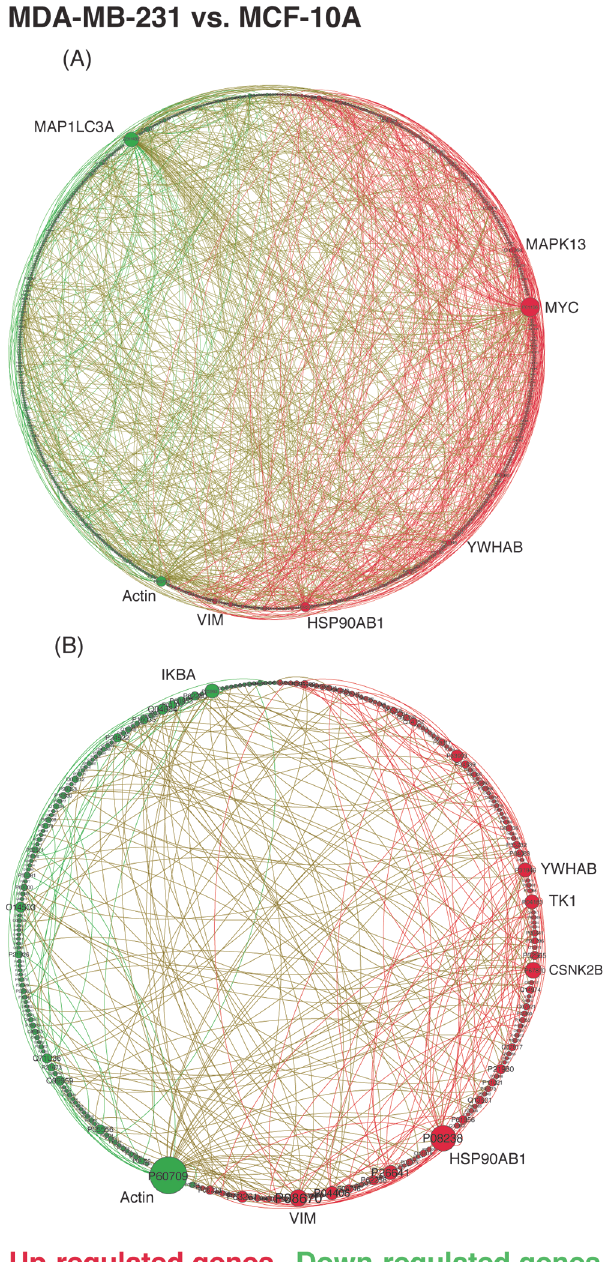
Figure 2. Sub-network of differentially expressed genes between MDA-MB-231 (Triple-Negative) and MCF10A, represented in a circular layout. Nodes represent genes while links represent interaction between genes. Size nodes indicate connectivity and color represents an expression pattern between tumoral versus non-tumoral breast cell line. (A) p < 0.05. (B) p < 0.01. Gephi was used to present and visualize the